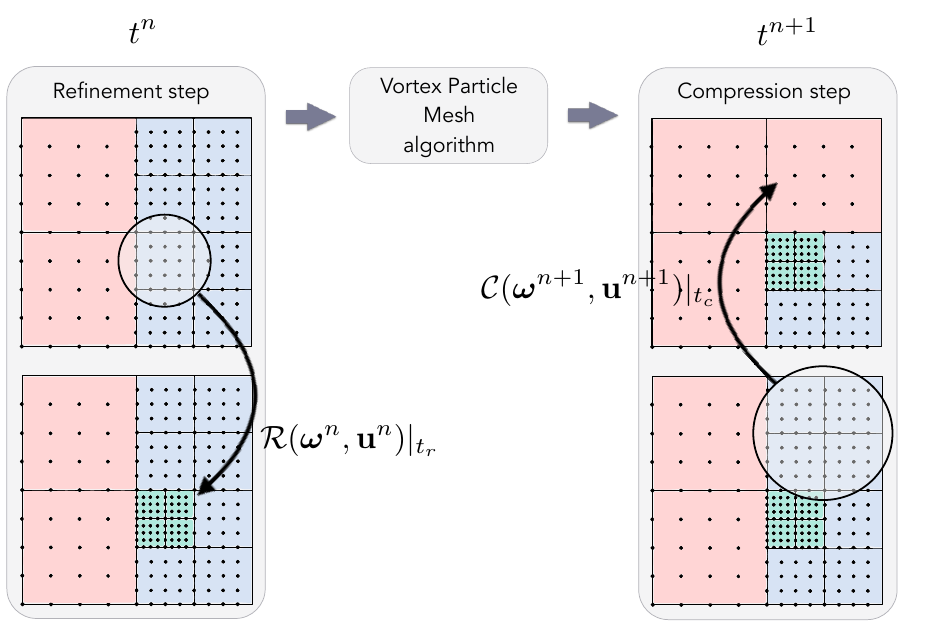
Figure 9. Sketch of refinement/computations/compression process within one time step of Vortex- Particle-Mesh method with wavelet-based Adaptive Mesh Refinement